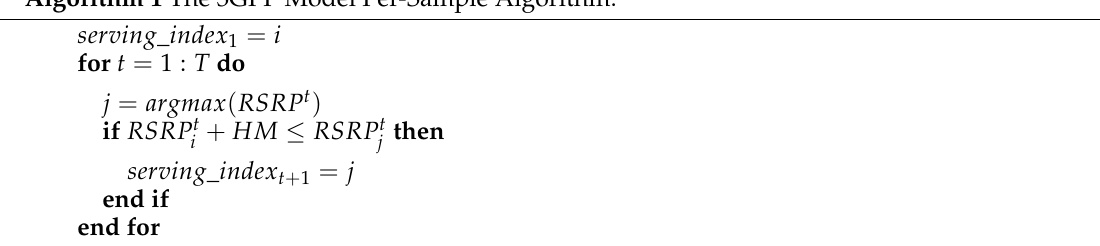
Algorithm 1 The 3GPP Model Per-Sample Algorithm.